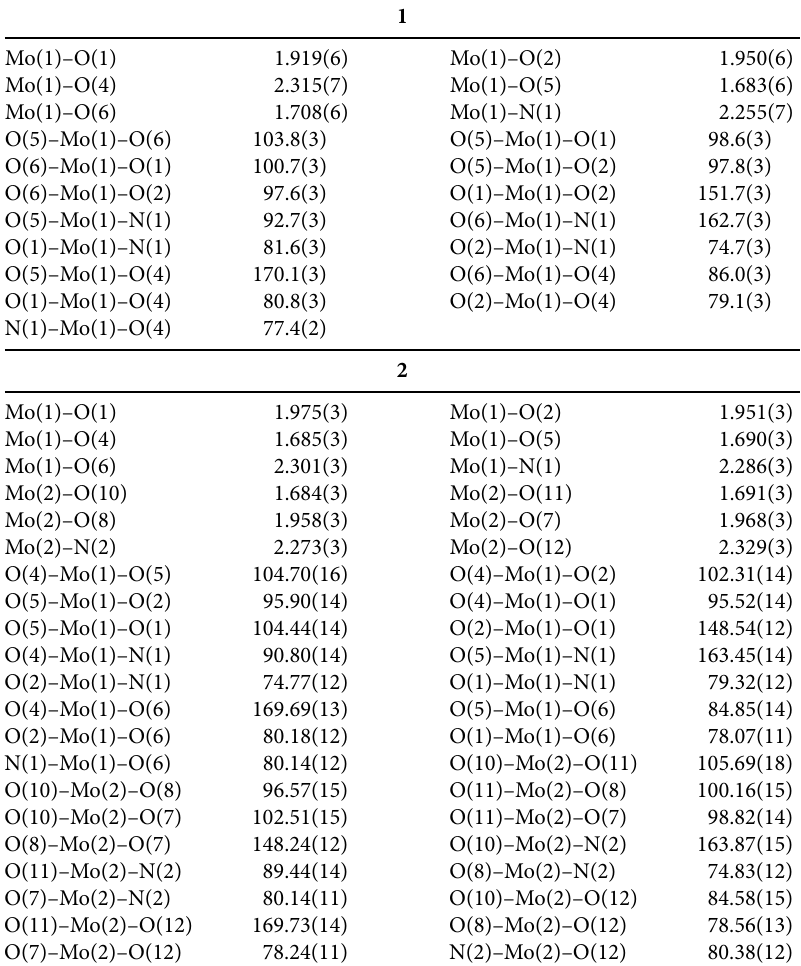
Table 2. Selected bond distances (Å) and angles (º) for the